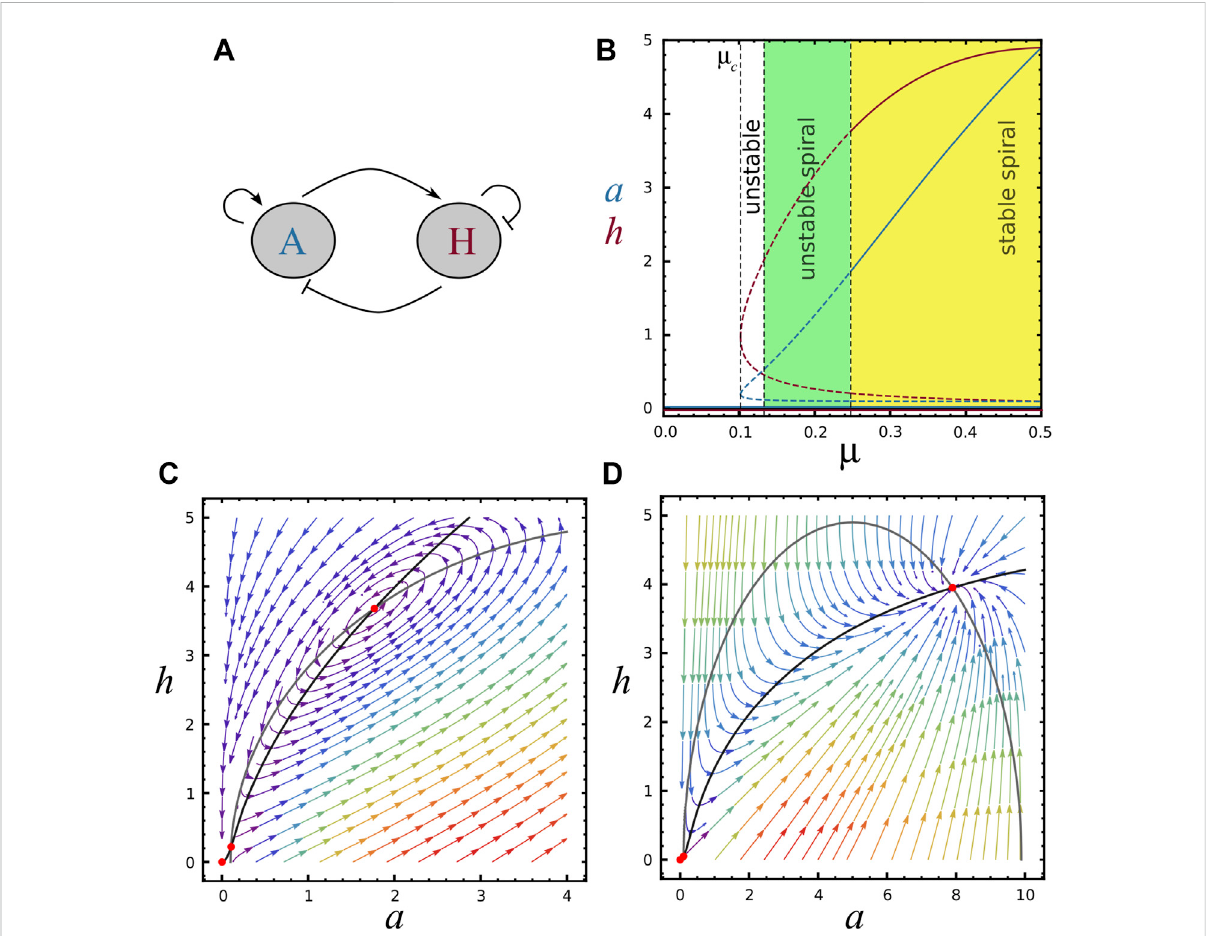
FIGURE 1 Bifurcation diagram and nullclines, (A) Schematic representation of the two-component system, A is the activator morphogene (activates both reactants),Histheinhibitormorphogene(inhibitsbothreactants). (B) Bifurcationdiagramshowingthebehaviorofconcentrations a (blue)and h (red) asafunctionof μ ,with r a =10and r h =5.Thetrivial fi xedpoint S 0 =(0,0)ispresentforall μ values.Thesaddle-nodebifurcationat μ = μ c ≈ 0.10marksthe emergenceoftwonew fi xedpoints( S 1 and S 2 ).Continuousanddashedcurvesrepresentrespectivelyregionsofstableandunstablesteadystate solutions. Black vertical dashed lines refer to μ c and the stability of steady-state S 2 , indicating regions of unstable node (white area, where Tr A < 0, det A > 0 and Δ > 0), unstable spiral (green area, where Tr A < 0, det A > 0 and Δ < 0) and stable spiral (yellow area, where Tr A > 0, det A > 0 and Δ < 0). For > 0). For visualisation in the phase diagram, see horizontal line in Supplementary Figure S1B. μ = μ 2 the system displays a limit cycle (Tr A =0 and det A (C) Blackandgreycurvesrepresent F and G functions(nullclines)fortheparametersvalue( μ , r a , r h )=(0.24,10,5)( S 2 isanunstablespiral). (D) Nullclines for the parameters value ( μ , r a , r h )=(1,10,5) ( S 2 is a stable node). Red points represent fi xed